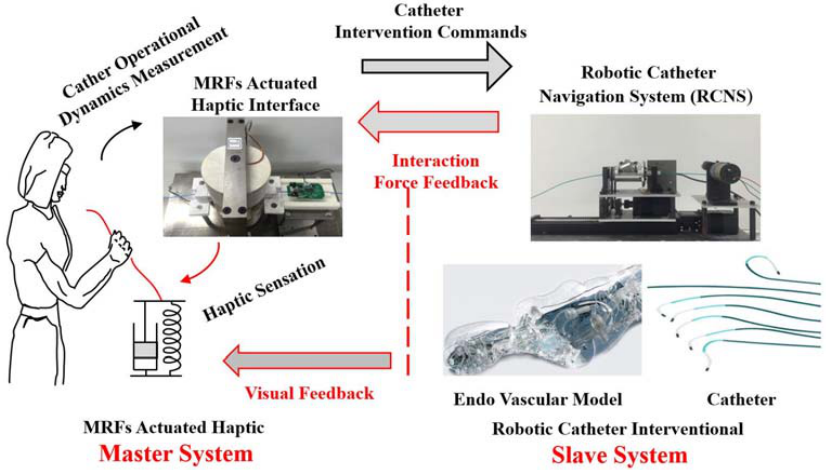
Figure 1. Schematic diagram of the master-slave catheterization system.